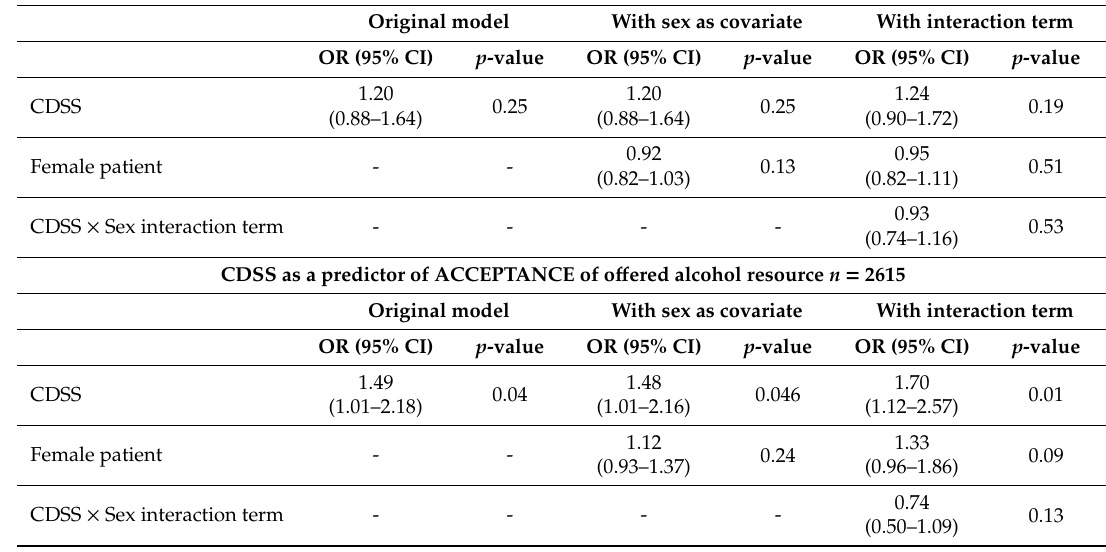
Table 2. Adjusted odds ratios and 95% confidence intervals for o ff er and acceptance of an educational alcohol